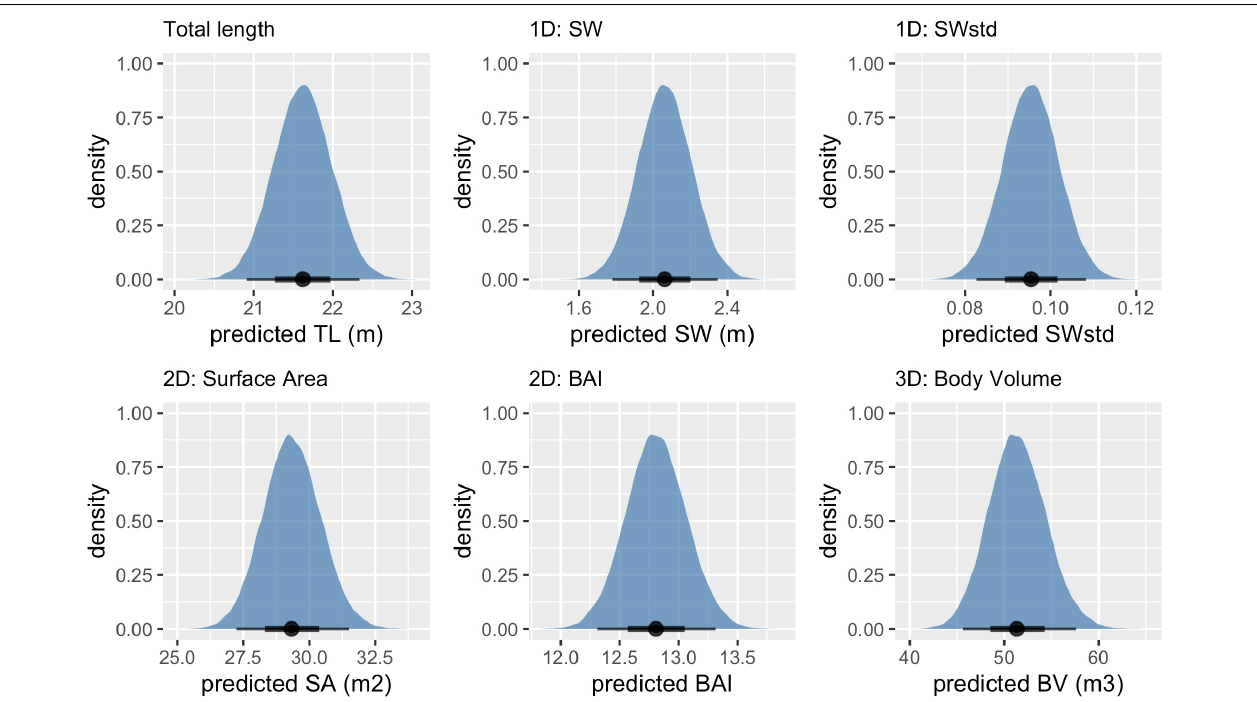
FIGURE 3 | Example of posterior predictive distributions of measurements and associated uncertainty from UAS images of an individual blue whale. Measurements include total length (TL), single-width (SW), single-width standardized (SW std ), surface area (SA), body area index (BAI), and body volume (BV). The longer thin black bars represent the 95% HPD interval, the thicker shorter black bars represent the 65% HPD interval, and the black dot represents the mean value. Note that each x -axis is on a different